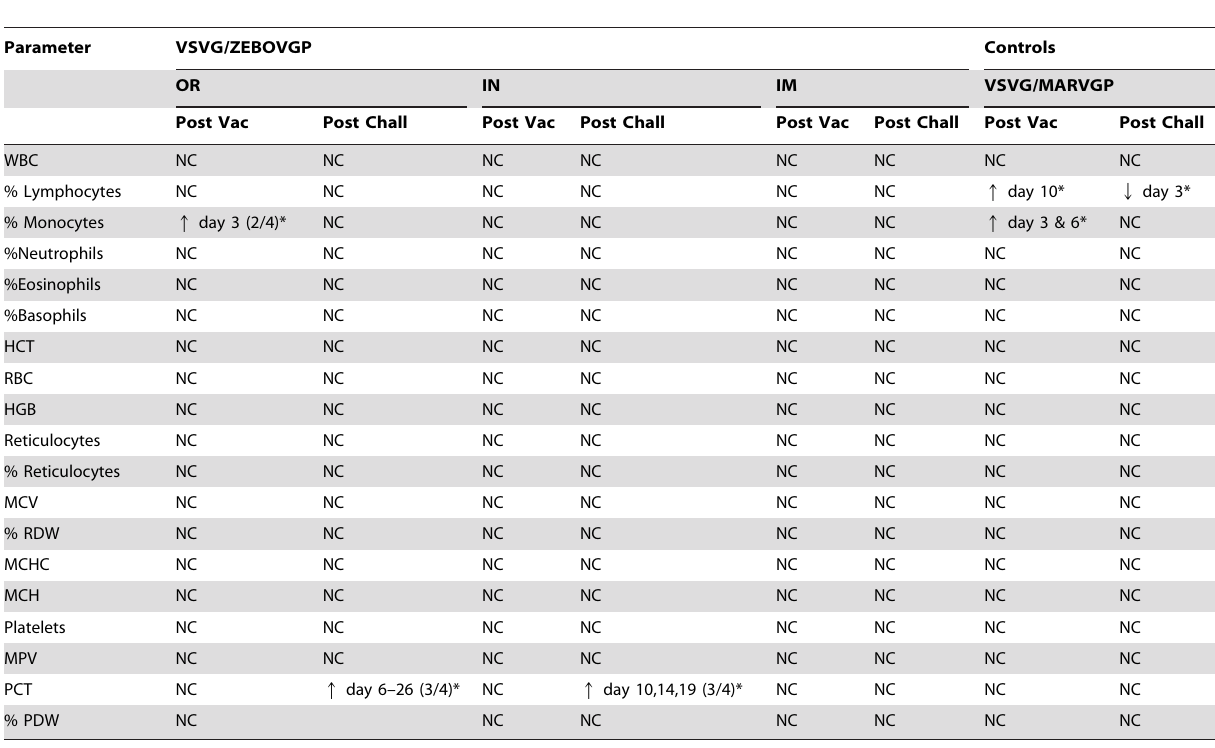
Table 1. Blood Hematology Results for Cynomolgus Monkeys after vaccination and challenge with Ebola Virus.